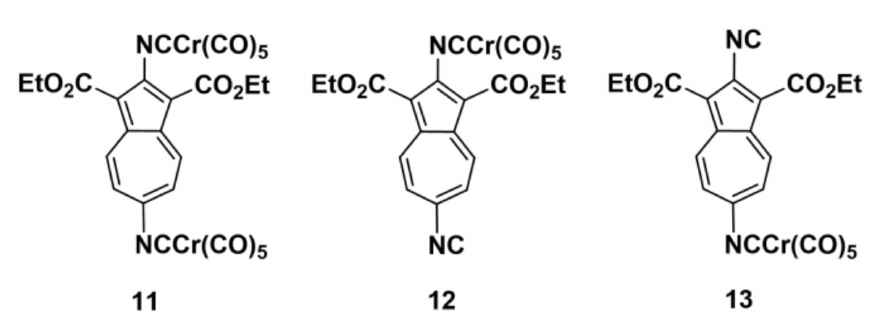
Figure 6. Di- and mononuclear complexes of 2,6-diisocyano-1,3-diethoxycarbonylazulene with [Cr(CO) 5 ] [34].